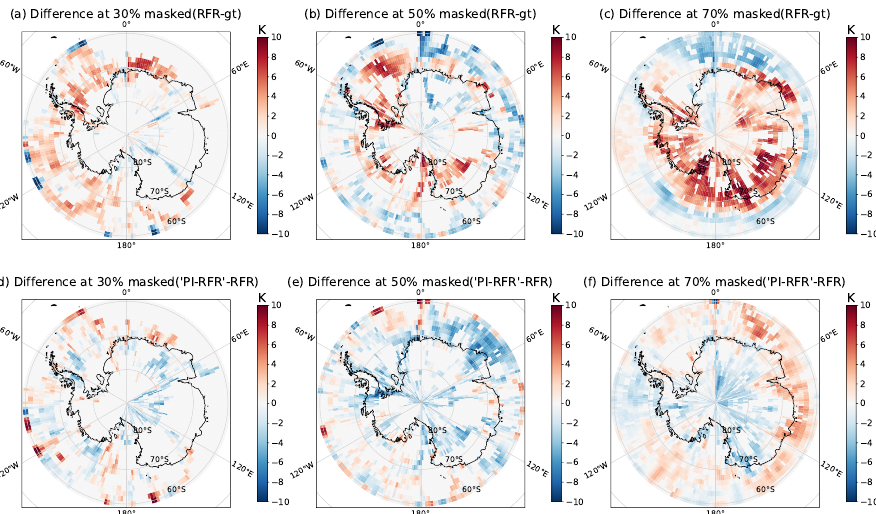
Figure 10. Differences between the reconstructed skin temperature of RFR ( a – c ) and PI-RFR ( d – f ) and the ground truth with 30%, 50% and 70% missing rates, respectively.